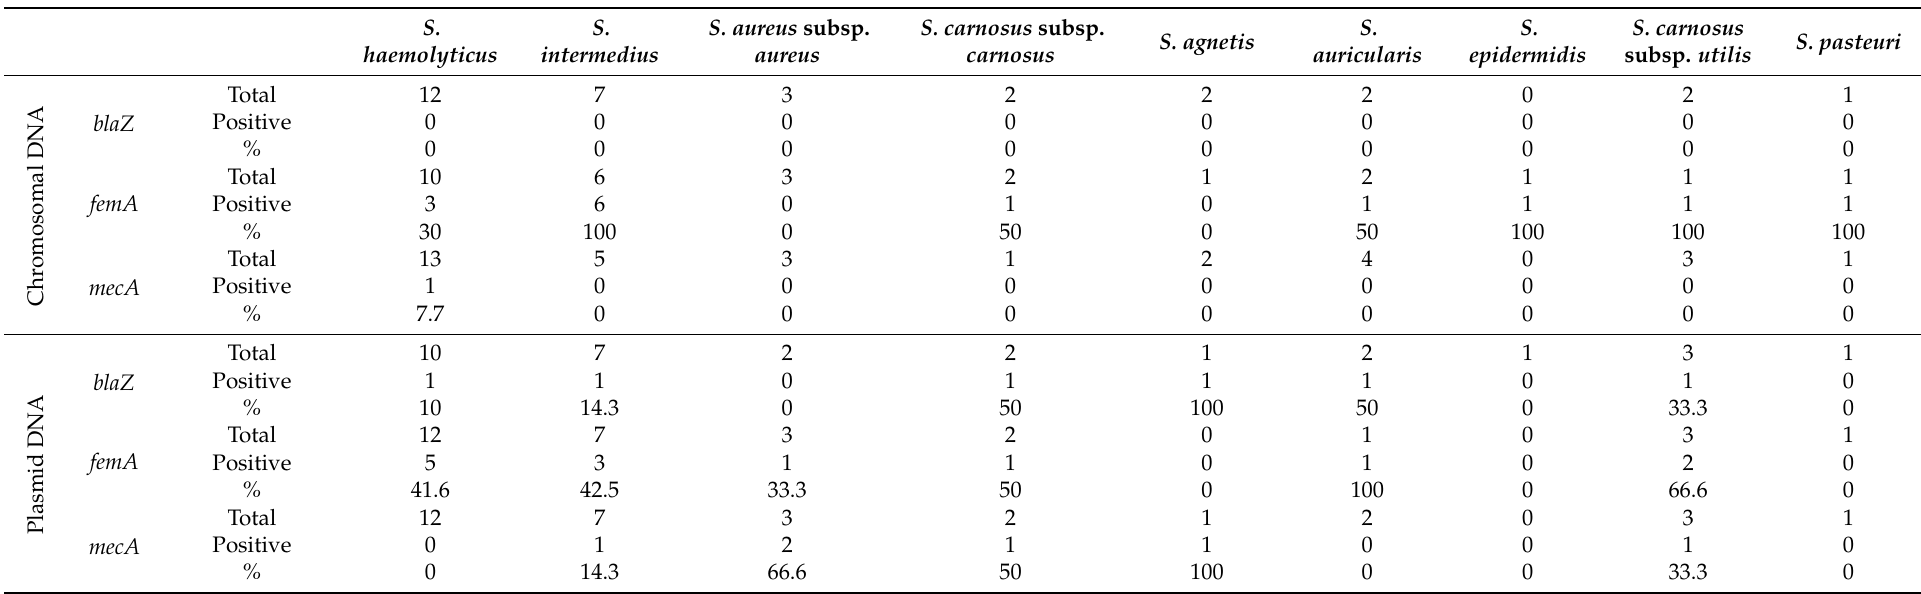
Table 1. Proportion of the presence of blaZ , femA , and mecA genes in the chromosomal and plasmid DNA of Staphylococcus spp. tested.